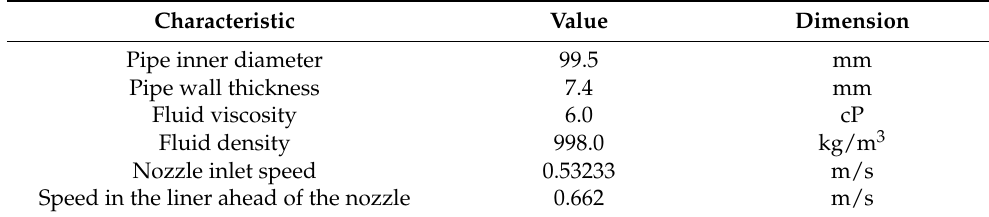
Table A1. The calculation of the parameters of the nozzle-type ICD for the well “XXX” from field